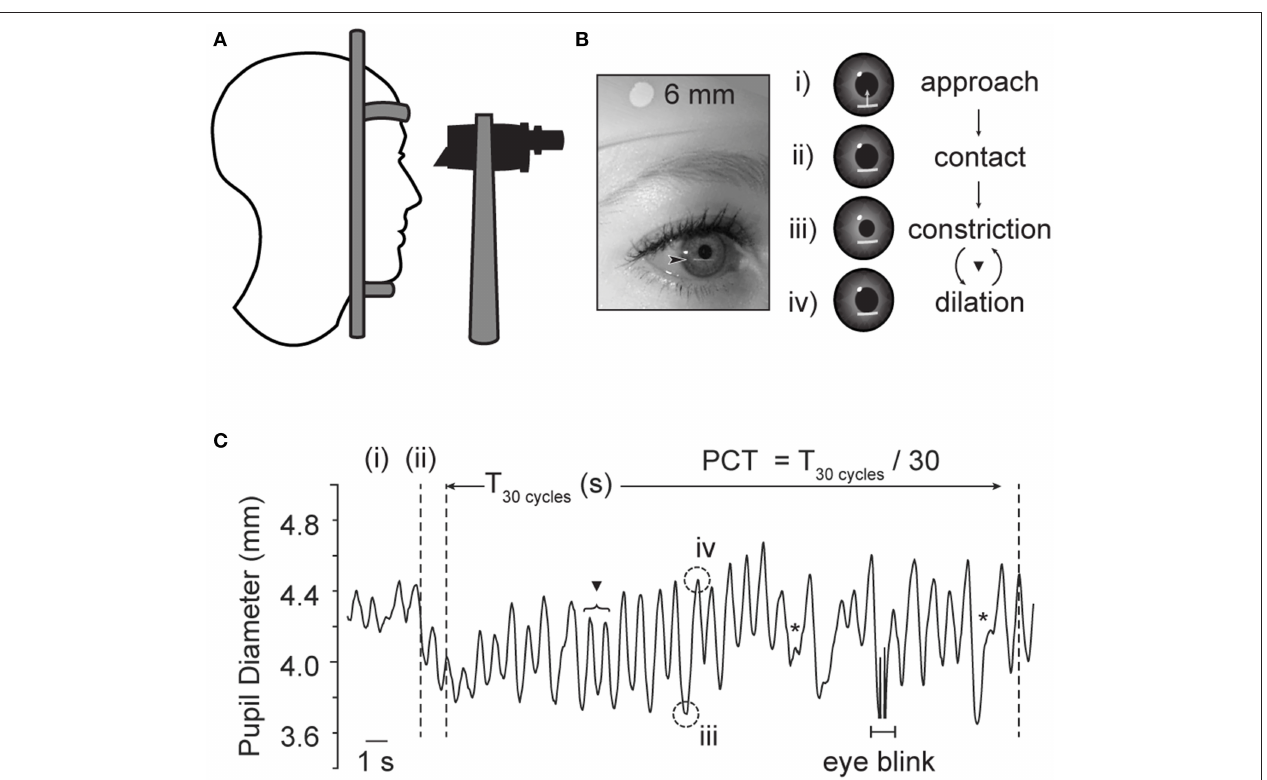
FIGURE 1 | Examination technique for edge-light pupil cycle time (PCT). (A) The subject is comfortably seated in front of a slit lamp, and the pupil visualized through the microscope. (B) A horizontal slit beam of light is positioned inferior to the plane of the iris, and elevated until contact is made with the pupillary margin, initiating constriction. The beam is held in place, so that the pupillary constriction brings the pupillary margin out of contact with the light. Once out of the light, the pupil then spontaneously re-dilates, eventually returning the edge of the pupil to contact the light beam once again. Thereby, this method produces a sustained oscillation between dilated and constricted states (C) . One cycle is the time it takes for a complete loop of the pupil reflex arc to be completed. H Denotes full cycle counted by PCT method. *Denoted superimposed beats of pupillary unrest, which are not thought to interfere in the oscillating rhythm of interest ( 12). Plot based on infrared pupil recording during routine PCT collection in a healthy subject, sampling rate 30Hz. Acknowledgments: Jeremy Theriot for